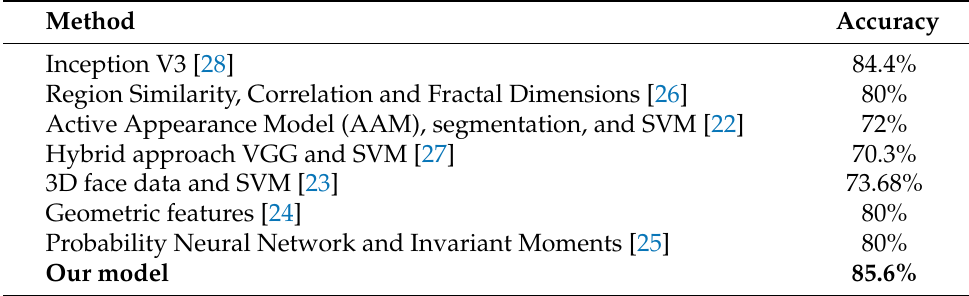
Table 2. The performance of proposed face shape classification methodology compared to the existing methods in the literature.